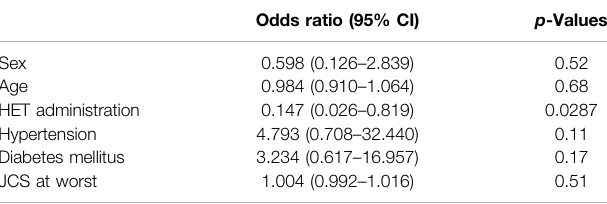
TABLE 3 | Multivariate analyses of the predictors for MRSA